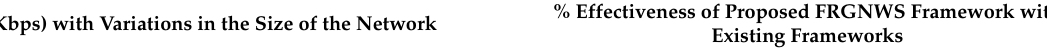
Table 10. The average % effectiveness of the proposed novel framework for the throughput metric with variations in the network